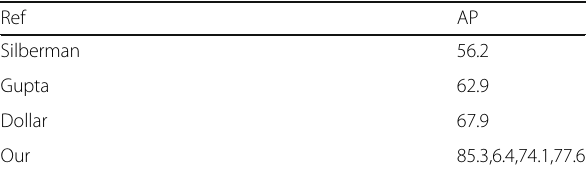
Table 2 Comparison of different